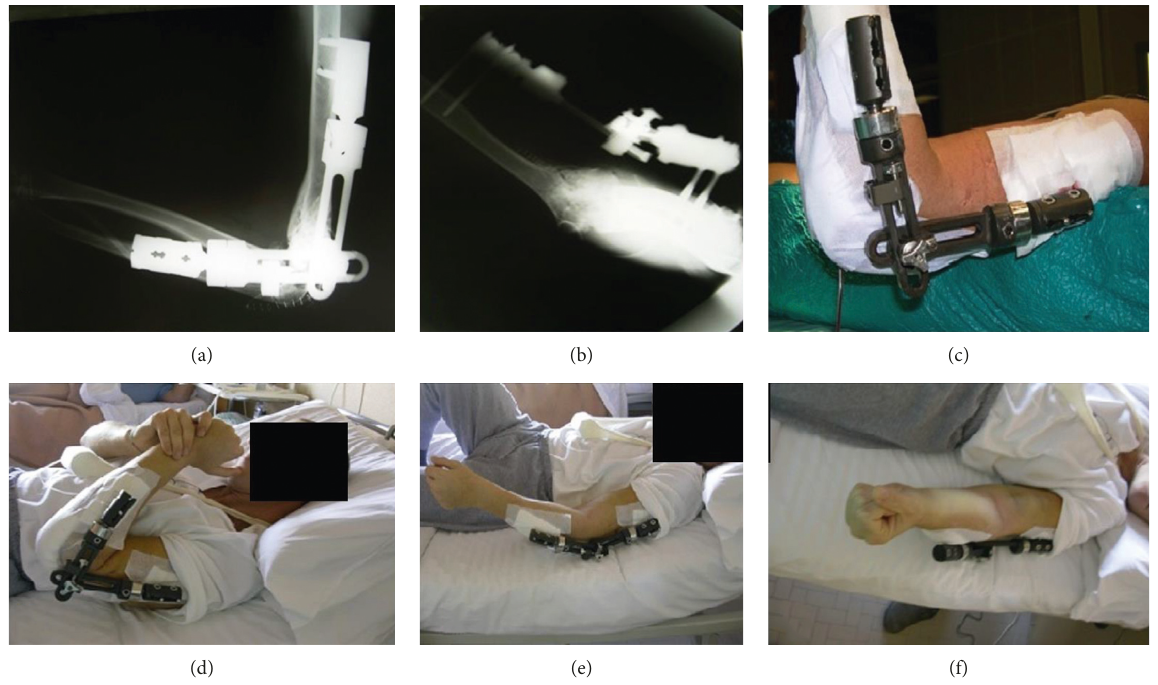
Figure 2: Postoperative situation. Postoperative radiographs after Grika interposition arthroplasty with hinged external fixator (a, b); active and passive motion during hospitalization